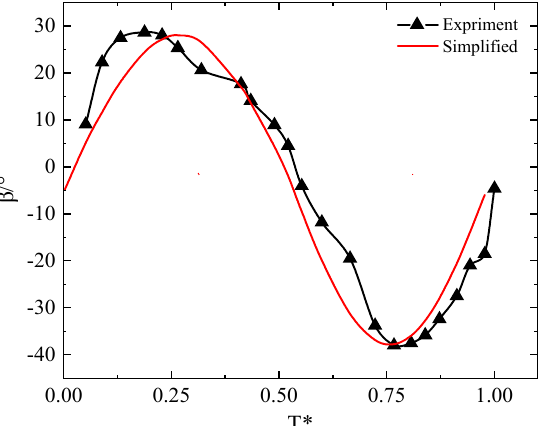
Figure 8. Periodic change curve of torsion angle in 0.71 span.